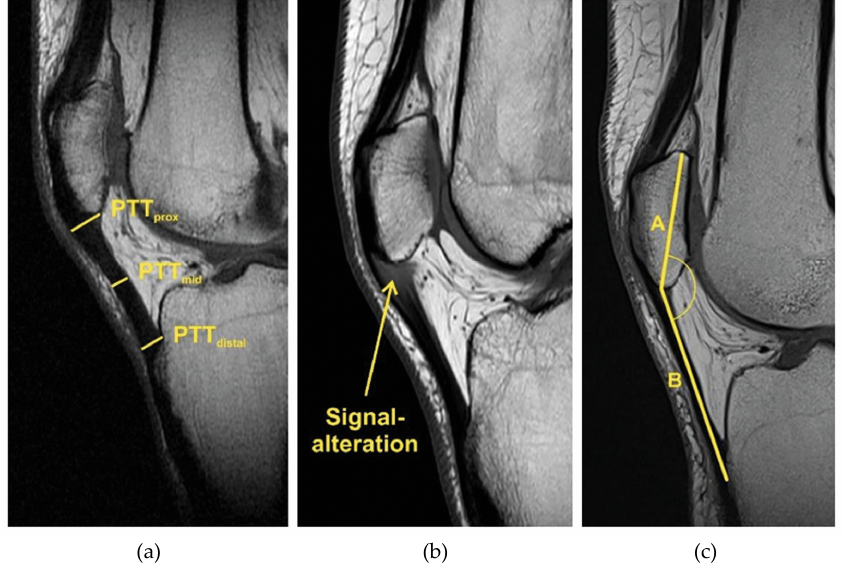
Figure 4. ( a ) Patellar tendon thickness (PTT): shown here on MRI, a thickened patellar tendon with PT in the proximal (PTTprox), middle (PTTmid) and distal segments (PTTdistal). ( b ) Signal intensity (alteration) in PT at the origin of the patellar tendon. ( c ) Patella–patellar tendon angle (PPTA): angle between the line drawn from the base of the patella to the apex (A) and the line drawn between the apex of the patella to the insertion of the patellar tendon on the tibial tuberosity (B).